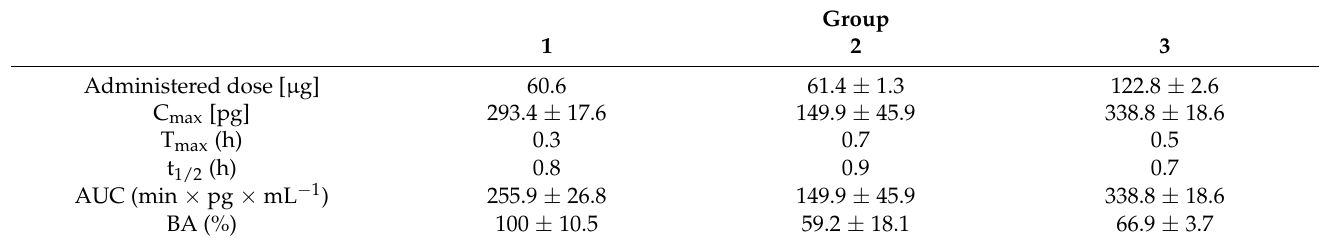
Table 1. Pharmacokinetic profiles of teriparatide acetate (TA)-administered rats.